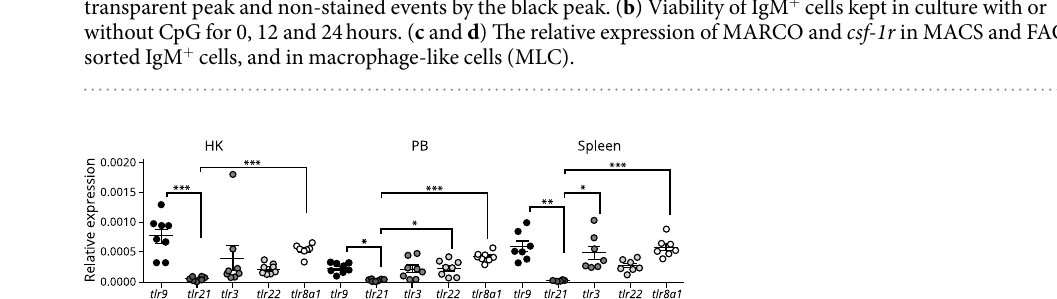
Figure 3. Relative expression of nucleic acid-sensing TLRs in Atlantic salmon IgM + B cells derived from head kidney, peripheral blood (PB) and spleen. tlr expression was analyzed by RT-qPCR in IgM + B cells sorted by MACS (n = 6 to 8). Data are presented as relative expression from individual fish (dots) where the bars indicate mean and s.e.m. Statistical significance between the tlr expression levels are indicated by brackets and the asterisks indicates the strength of significance: * p < 0.05 ** p < 0.01 *** p <